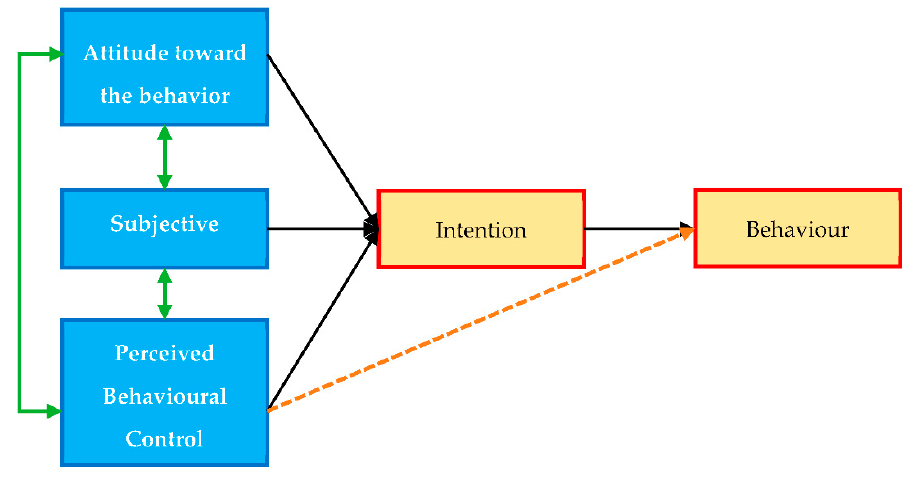
Figure 2. Theory of planned behavior.